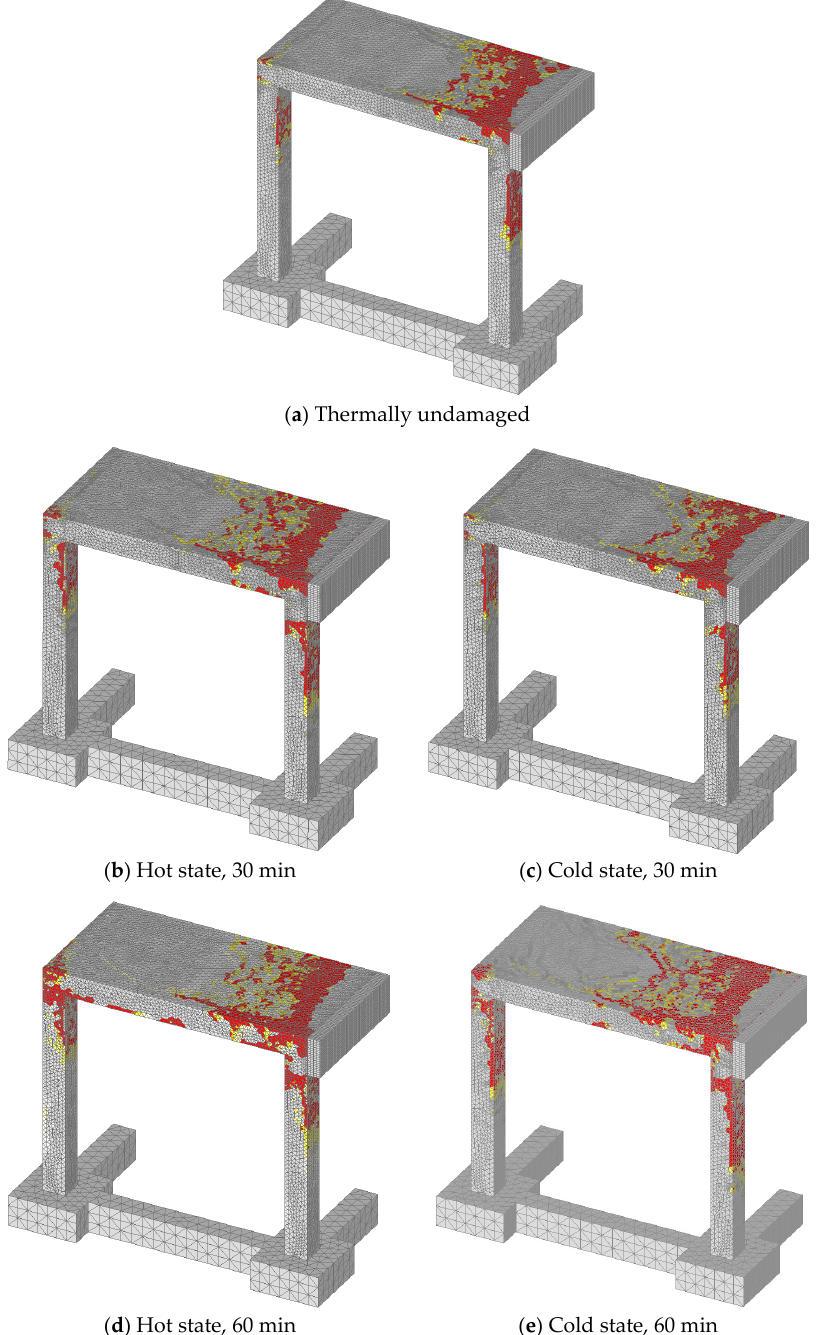
Figure 15. Localization of damage in concrete after peak resistance.